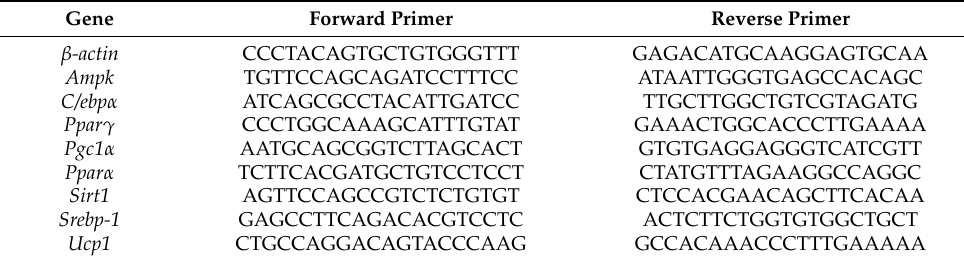
Table 1. Sequences of primers used for PCR.